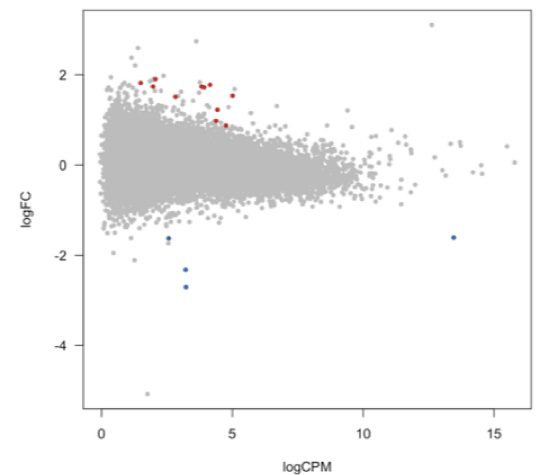
Figure 2. Di ff erential regulation of lncRNAs in medial frontal gyrus in bipolar disorder. This MA plot depicts the 15 di ff erentially expressed lncRNA transcripts at FDR < 0.1. On the x -axis, the logCPM is the log-transformed average expression level (expressed in CPM, counts per million mapped reads) for each gene across the two groups; on the y -axis, the logFC represents the log of the ratio of expression levels for each gene between two experimental groups. In red are the upregulated transcripts; in blue the downregulated